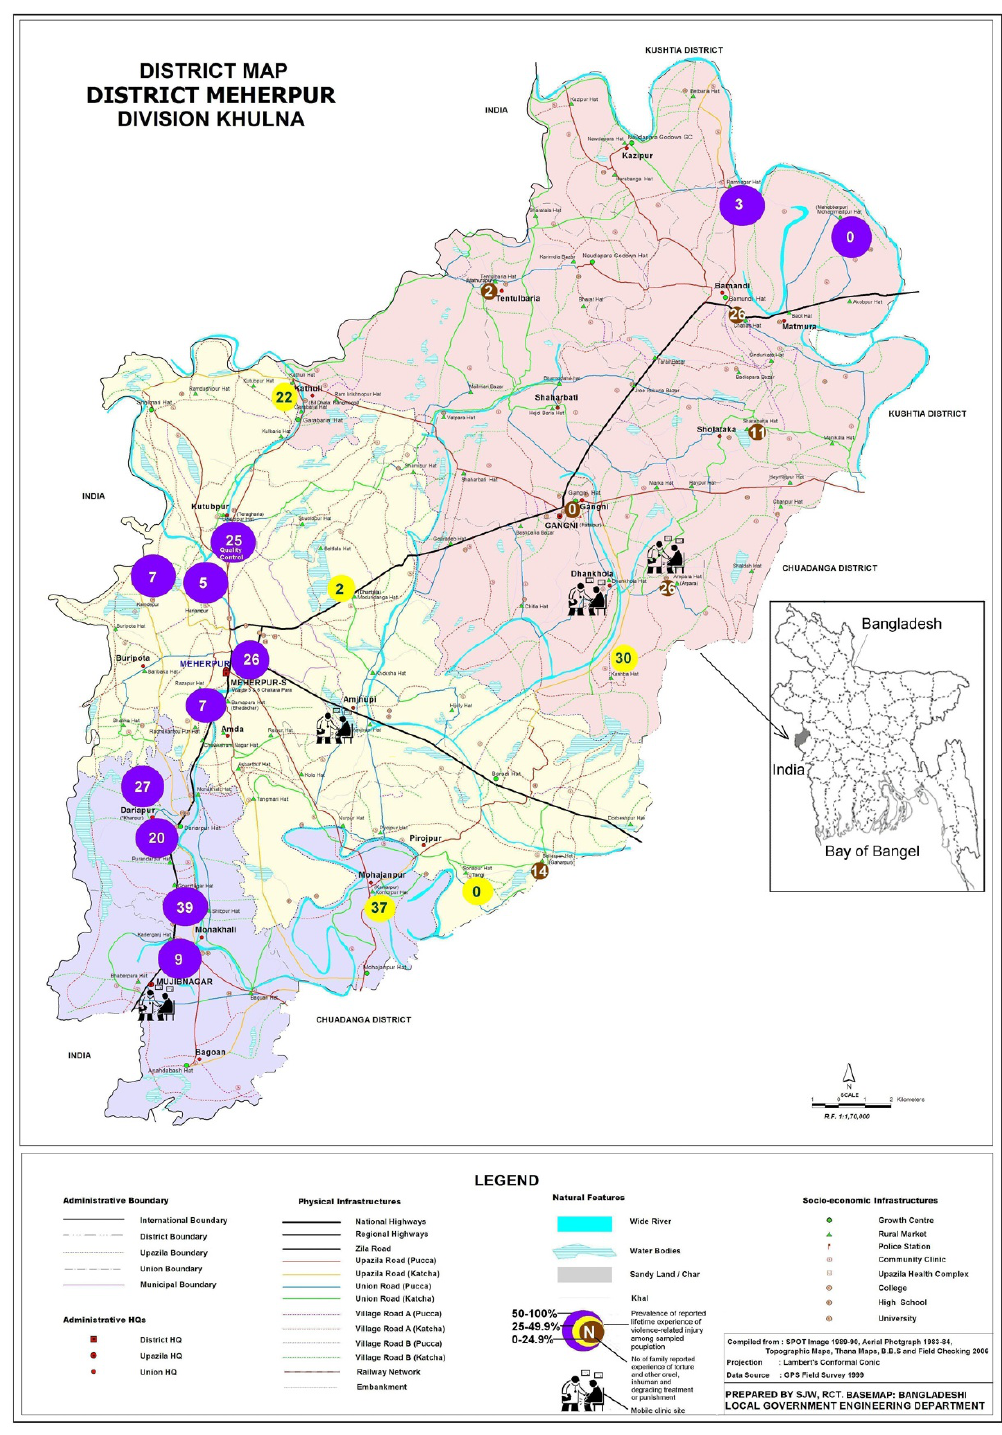
Figure 2 Spatial variations in the proportion of sampled populations with lifetime experience of violence-related injury and the number of sampled households reporting experience of torture and other cruel, inhuman or degrading treatment or punishment . February--March 2008, Meherpur